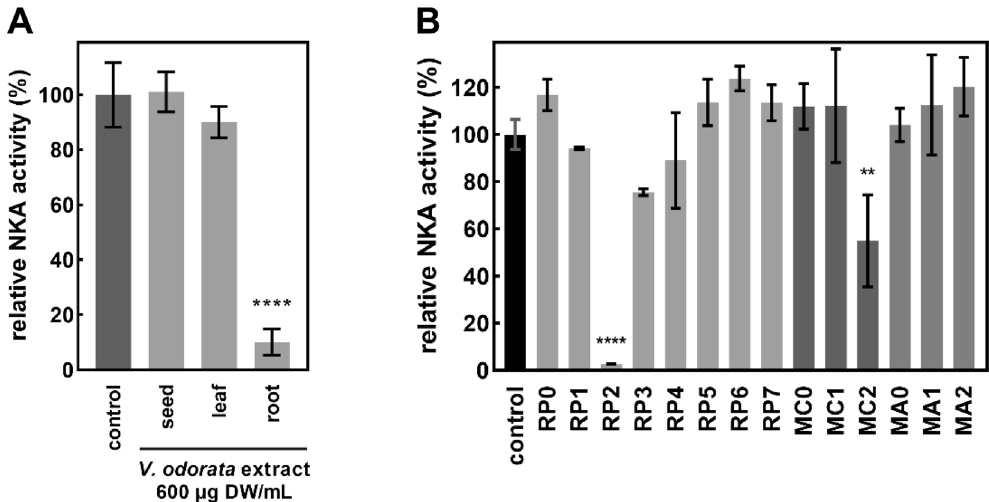
Figure 1. ( A ) Relative NKA activity (%) of Na + ,K + -ATPase treated with crude methanolic Viola odorata extracts. Data are expressed as means ± SD (n = 3–4); Statistical significance based on Tukey’s test is indicated by **** for p < 0.0001. ( B ) Relative NKA activity (%) of Na + ,K + -ATPase treated with V. odorata root